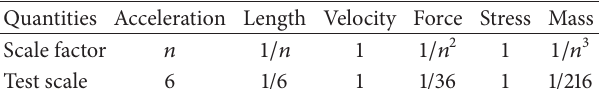
Table 2: Similar scale between Earth and